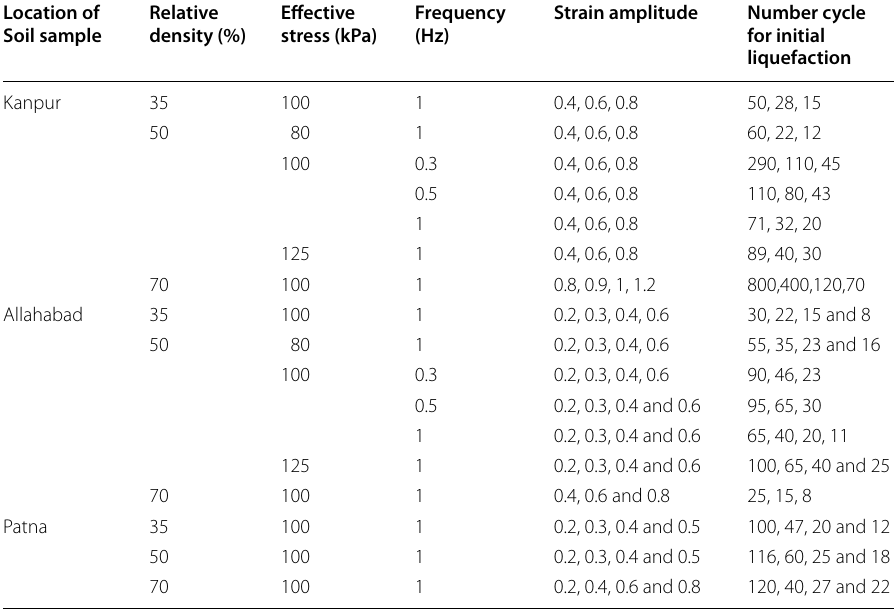
Table 3 Number of cycles required for initial liquefaction of soils from Kanpur, Allahabad and Patna Location of Soil sample